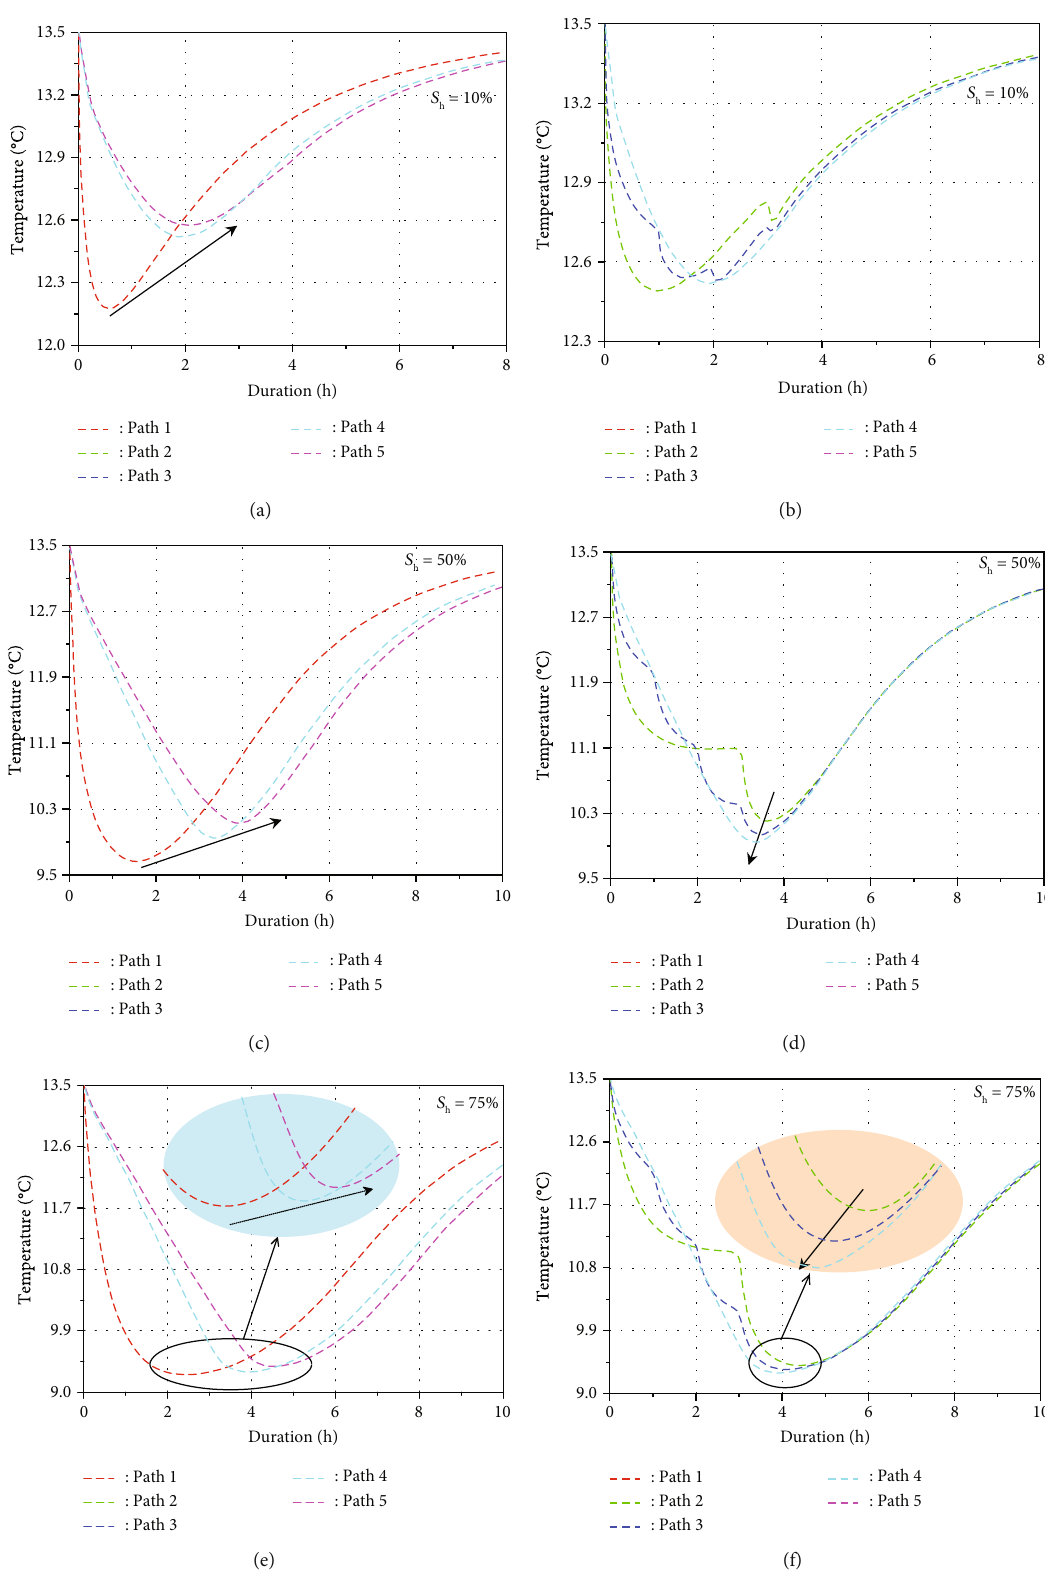
Figure 10: Temperature changing behaviors at the core of the model (point A). Panels (a), (c), and (e) compare the di ff erences among pressurization pathways 1, 4, and 5; panels (b), (d), and (f) compare the di ff erences among pressurization pathways 2, 3, and